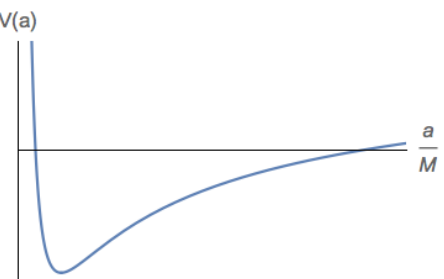
Figure 7. Schematic potential of a globally stable